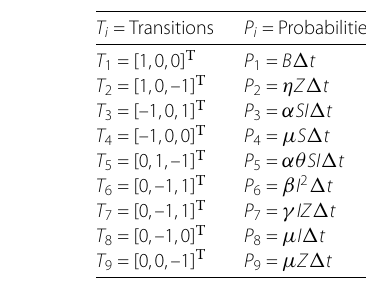
Table 1 Transition of meme